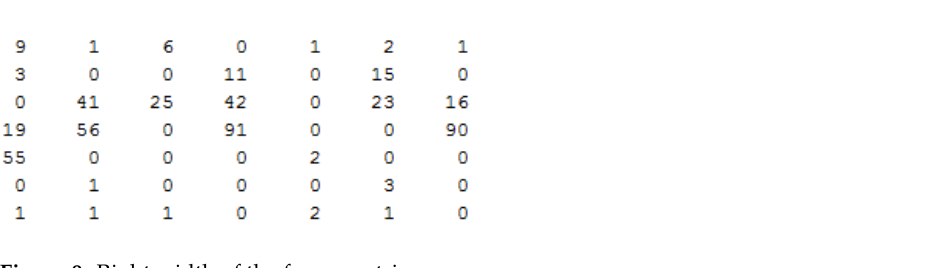
Figure 9. Right width of the fuzzy matrix.